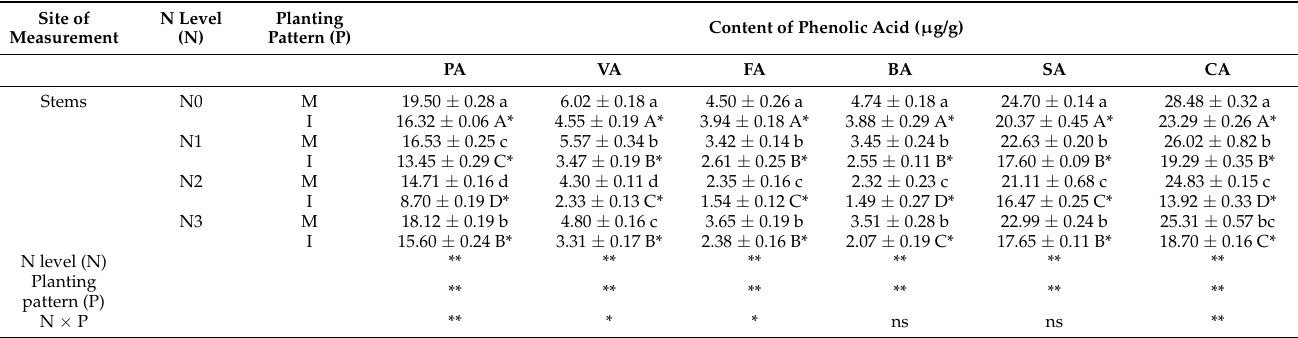
Table 3. Effects of nitrogen application and intercropping on phenolic acid content in faba bean stems.